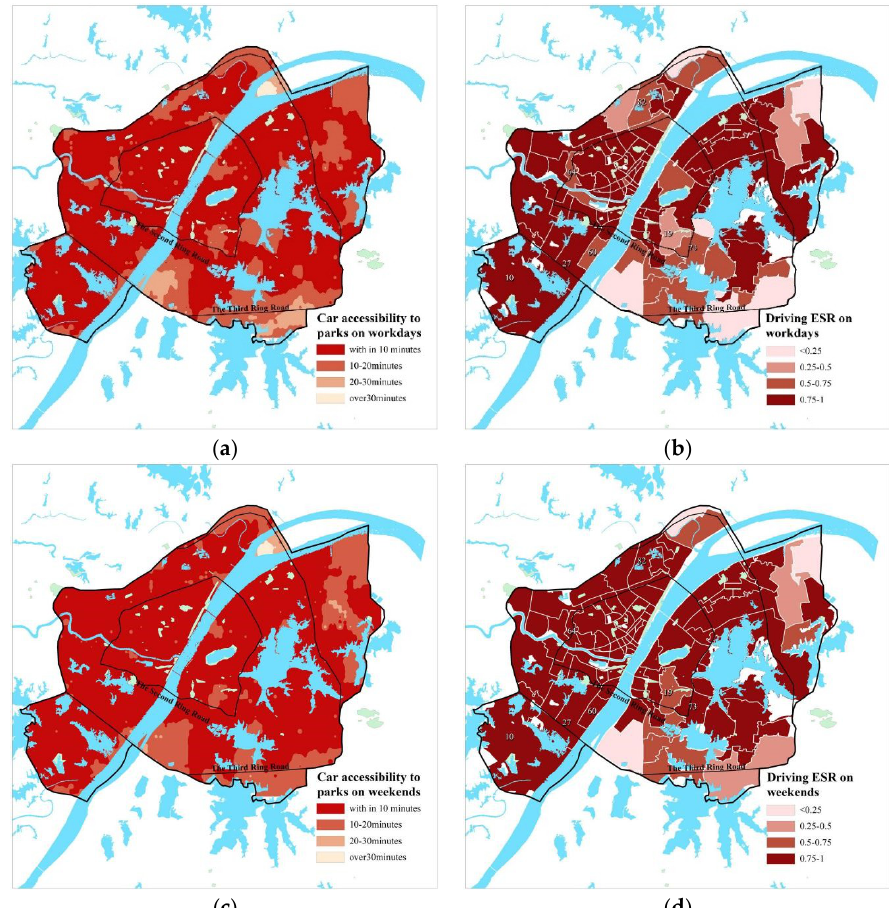
Figure 4. ( a ) Spatial distribution of car accessibility on workdays; ( b ) Spatial distribution of car ESR on workdays; ( c ) Spatial distribution of car accessibility on weekends; ( d ) Spatial distribution of car ESR on weekends.